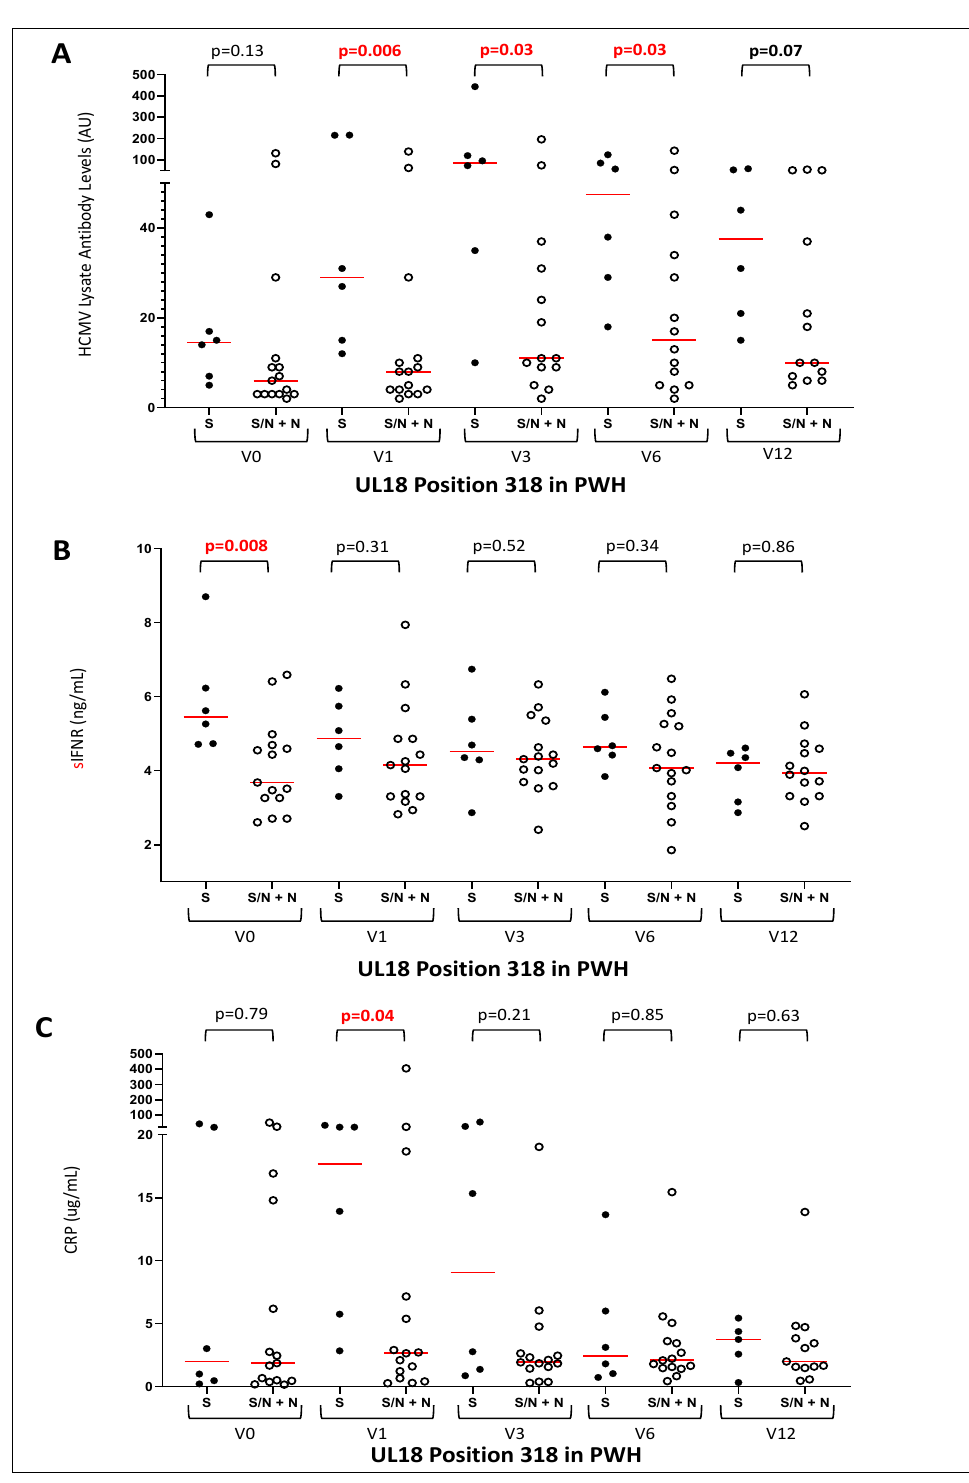
Figure 2. PWH with S318N carried lower levels of HCMV-reactive antibodies and/or inflammatory biomarkers over 6 months on ART. ( A ) comparison of HCMV lysate-reactive antibodies in PWH with S at position 318 and those with either S/N or N over time on ART. ( B ) plasma soluble IFN α R levels in PWH with HCMV with S at position 318 versus those with S/N or N; ( C ) plasma CRP levels in PWH with HCMV with S at position 318 versus those with S/N or N. V0 = before ART; V1, V3, V6, V12 = 1, 3, 6 or 12 months on ART resp. Red lines mark median